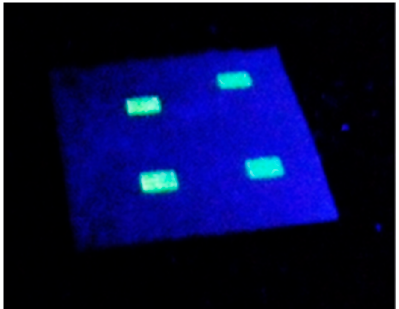
Figure 10. Photograph of the P8T2 IJMP imprinted film on ethylcellulose under UV light. Table 3. Decay times of the F8T2 and F8BT imprinted by IJMP in ethyl cellulose film in presence or absence of nitroaromatics vapors. F8T2